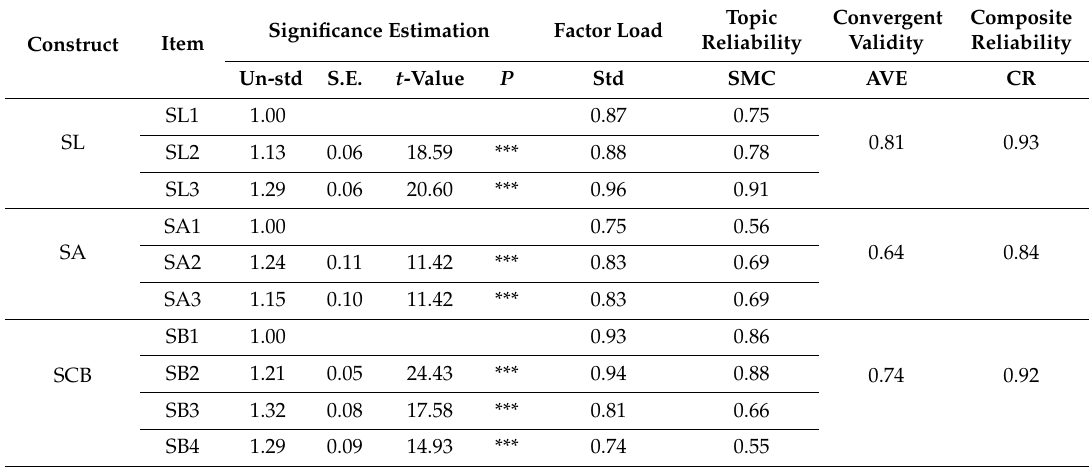
Table 3. Parameter significance estimation and convergence validity of the measurement model.